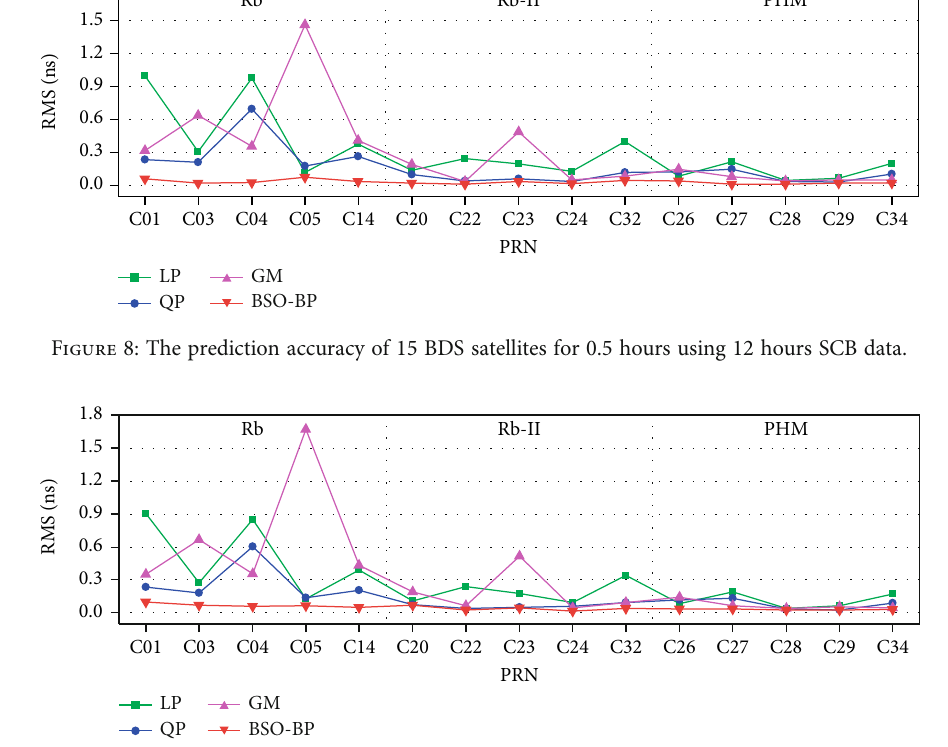
Figure 9: The prediction accuracies of 15 BDS satellites for 1 hour using 12 hours SCB